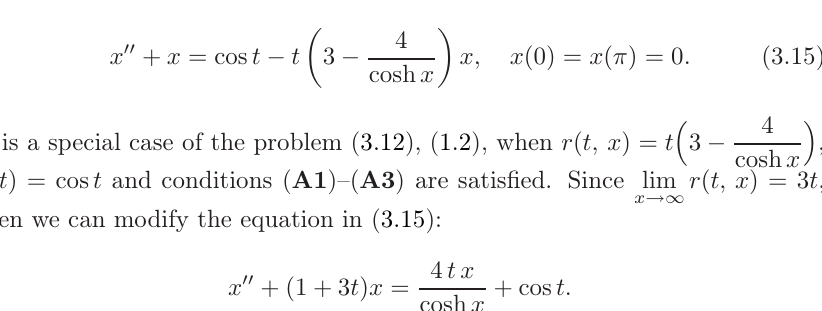
0 . 11 . Fig. 8 b illustrates − 0 . 1 ) and −